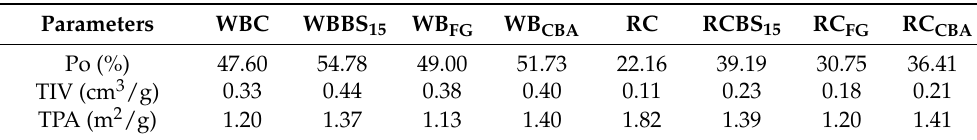
Table 5. LWA total intrusion volume (TIV) and total pore area (TPA) by mercury intrusion porosimetry (MIP).